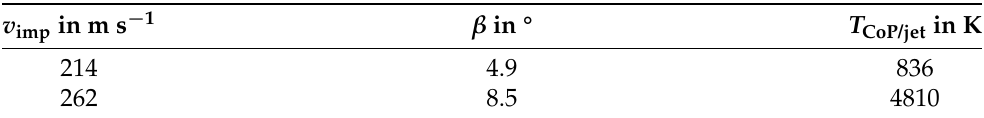
Table 4. The temperature of the CoP and/or jet T CoP/jet at different impact velocities v imp and collision angles β calculated by Equation